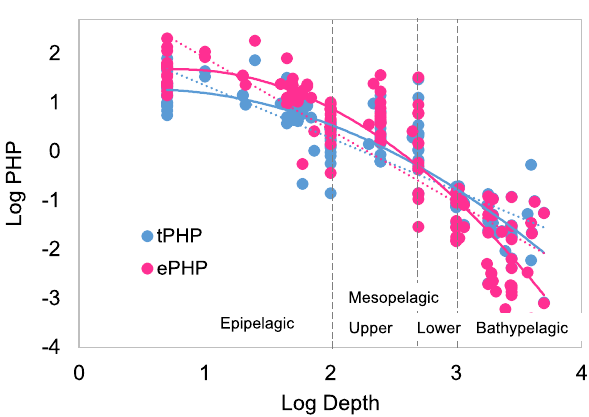
Figure 2. Log–log relationship between depth (m) and PHP (μmol C m −3 d −1 ), derived from empirical and theoretical conversion factors (ePHP in fuchsia and tPHP in light blue, respectively). Dashed and solid lines represent, respectively, linear and quadratic models fitted to data. Akaike’s Information Criterion (AIC, in brackets) was used for the selection of the best fitted model (lower AIC). For theoretical estimates, the linear model was y = − 1.08x + 2.43 (R 2 = 0.75) [AIC = 232.11], and the quadratic model was y = -0.33x 2 + 0.35x + 1.19 (R 2 = 0.80) [AIC = 200.80]; for empirical PHP, the fitted linear model was y = 1.48x + 3.40 (R 2 = 0.76) [AIC = 311.05], and the quadratic model was y = 0.55x 2 + 0.88x + 1.33 (R 2 = 0.84) [AIC =